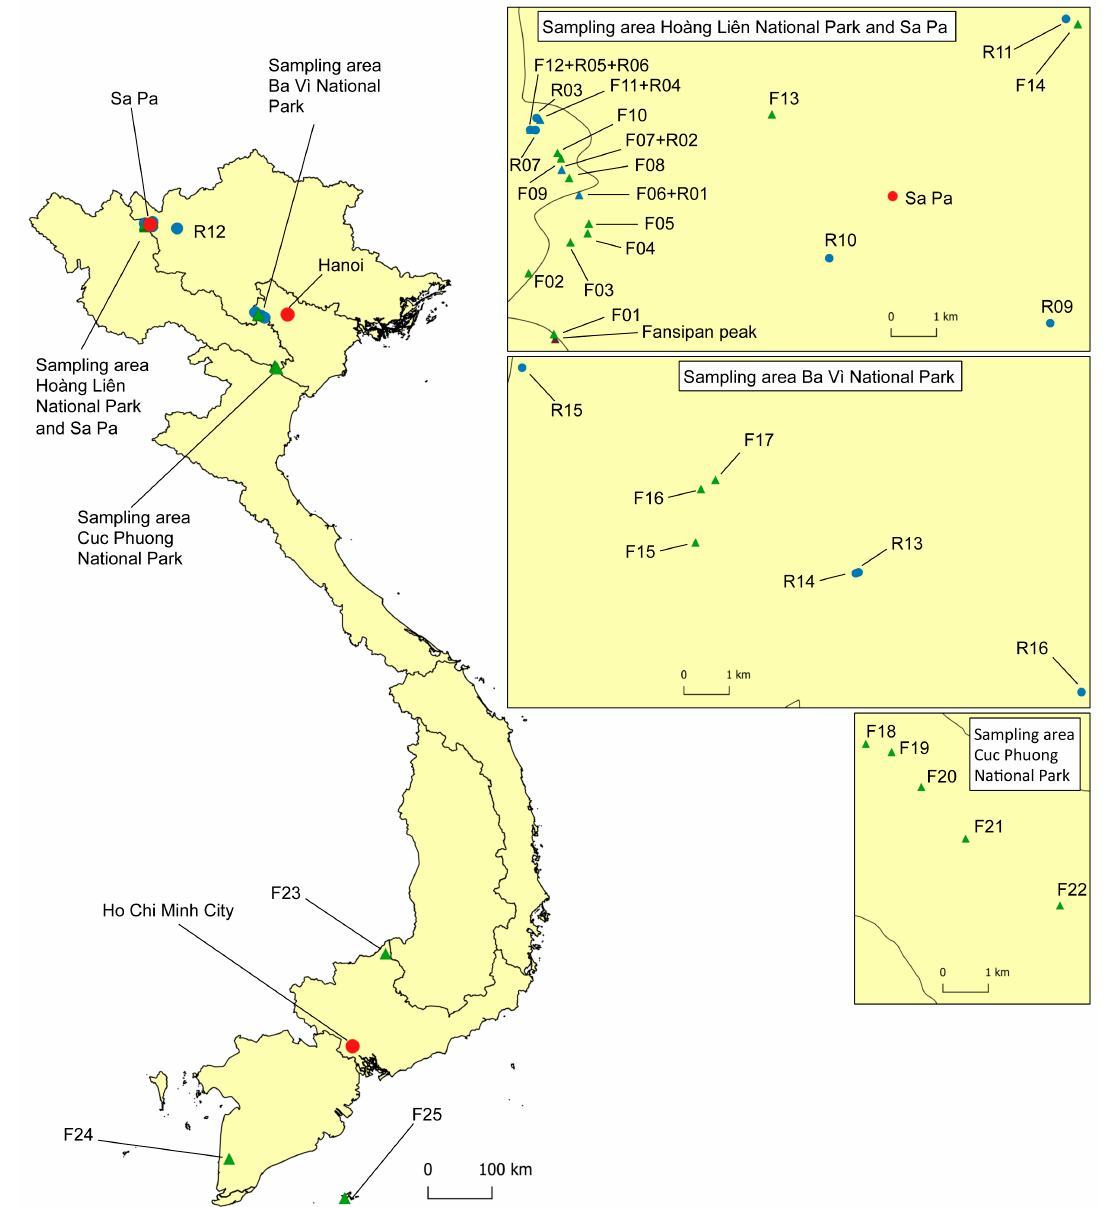
Figure 1. Location of the 25 forest sites (F01–F25; green triangles) and the 16 riparian sites (R01–R16; blue dots) included in the Phytophthora survey in Vietnam; blue triangles represent sites included in both the riparian and forest survey. For geographical coordinates and details of sites see Tables 1 and 2.